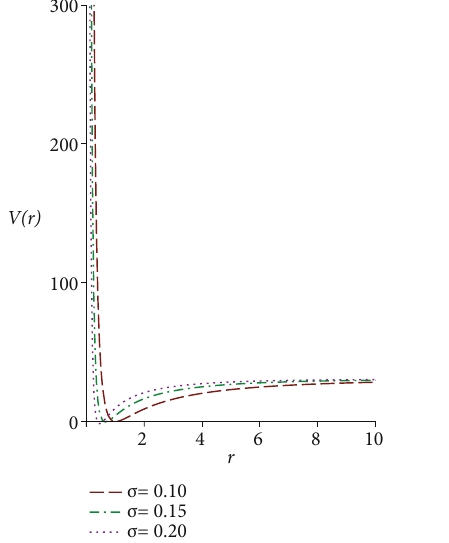
Figure 2: Sketch of the composed-potential as a function of r ð r > 0 Þ for Η = 20 , T = 1 , and ϱ = 0 : 1 with σ = 0 : 1 , 0.15, and 0.2 :